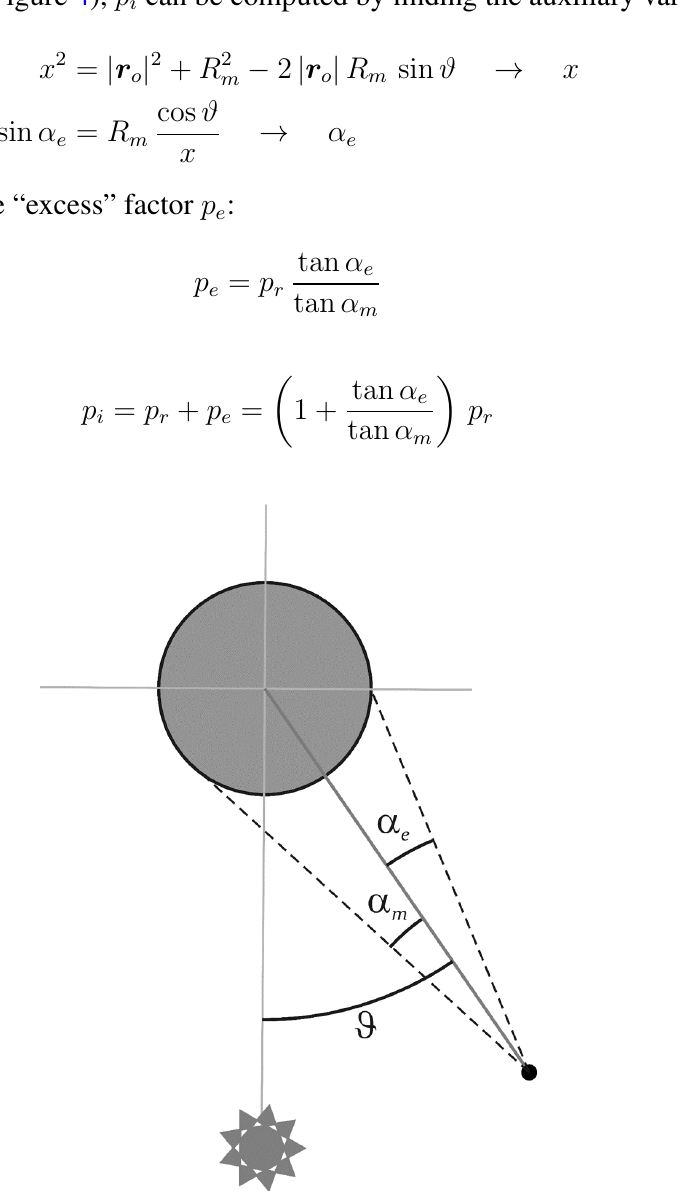
Figure 4. The gibbous Moon